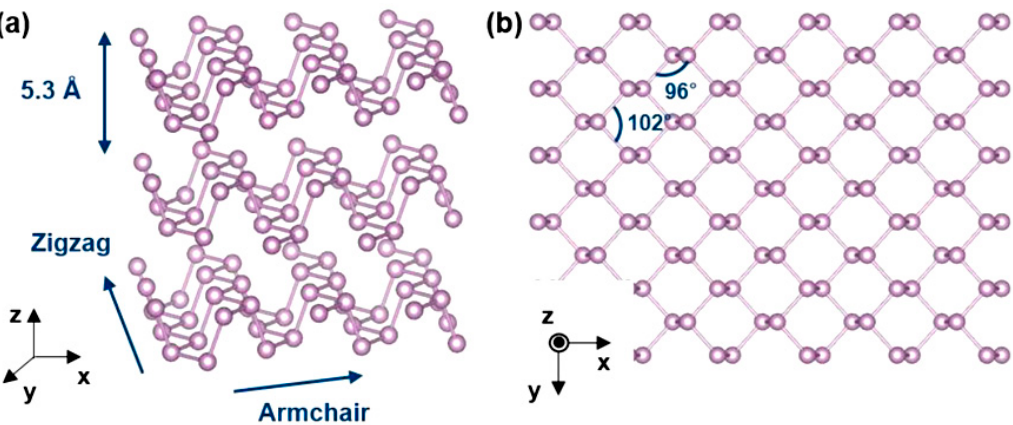
Figure 1. ( a , b ) Schematic diagram of the crystal structure of black phosphorus. The system is relaxed using density functional theory calculation. Reproduced with permission from Ref. [38]. Copyright American Chemical Society, 2009.